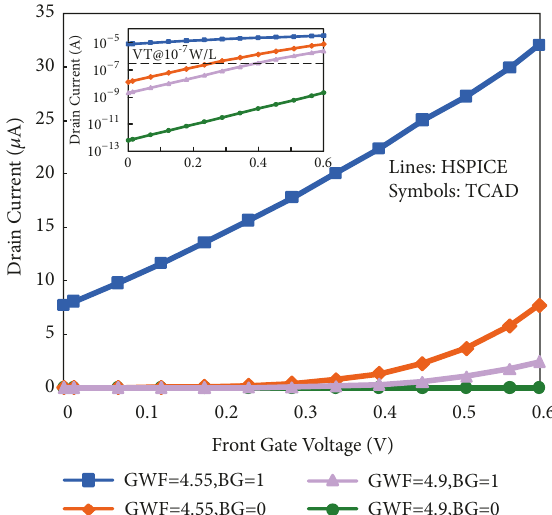
Lines: HSPICE Symbols: TCAD